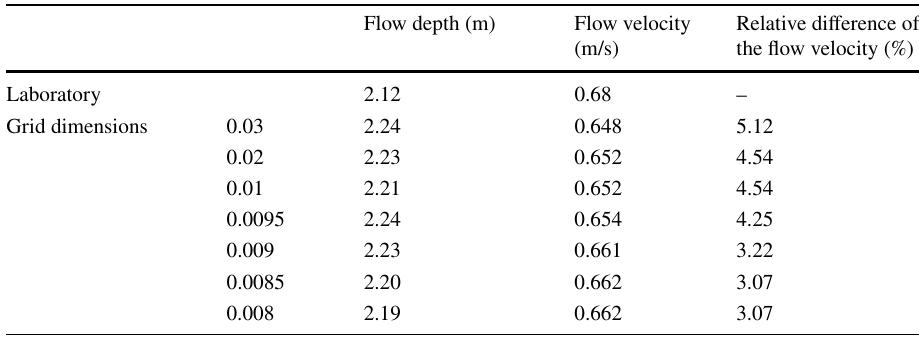
Table 2 Sensitivity analysis on grid dimensions in section